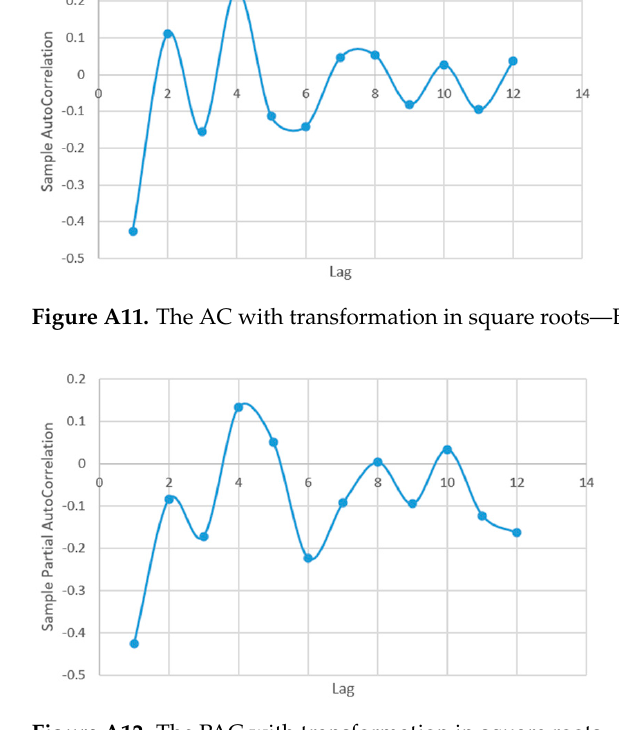
Figure A12. The PAC with transformation in square roots—BR series.